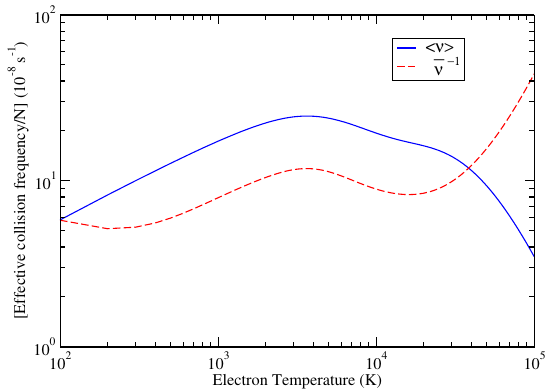
Figure 9. Effective collision frequencies: line curve, (cid:104) ν (cid:105) ; dashed curve, ν − 1 . Denoting σ i as the ionization cross sections for the i th-occupied molecular orbital, then the total ionization cross sections Q BEB for singly charged ions in the BEB model [52] are obtained by summing the ionization cross sections over all the occupied molecular